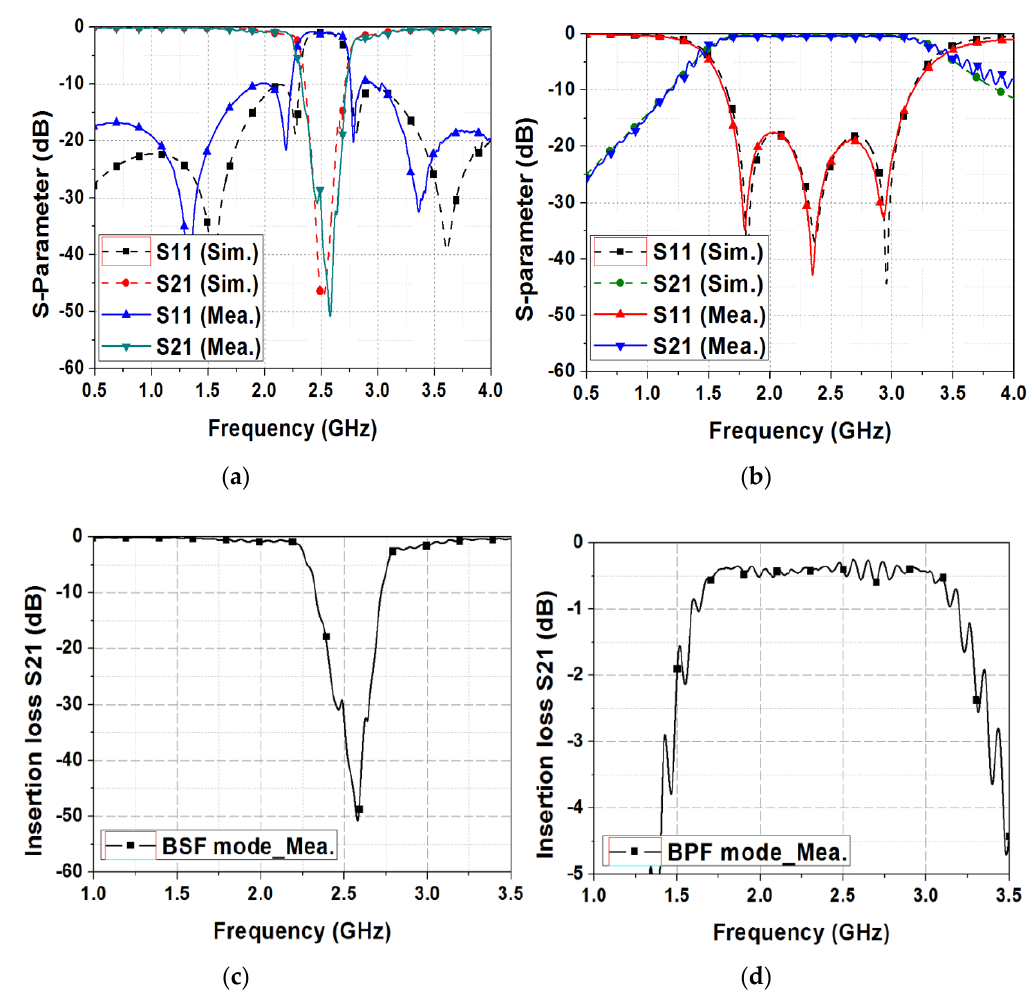
Figure 8. Simulation and measurement results when ( a ) the fluidic switch selects the open stub and ( b ) the fluidic switch selects the short stub. Measured insertion losses are depicted for ( c ) BSF and ( d )